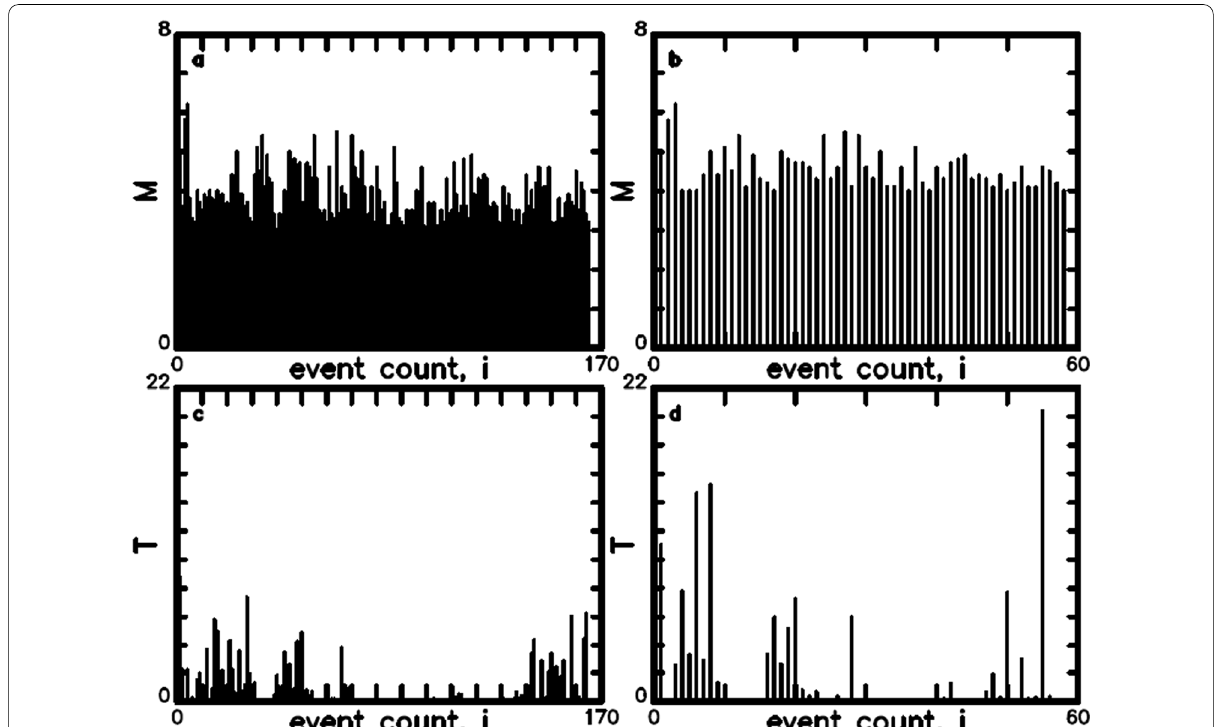
Fig. 7 The time sequences of earthquakes in natural time: a for magnitudes with M L for inter‑event times with M L